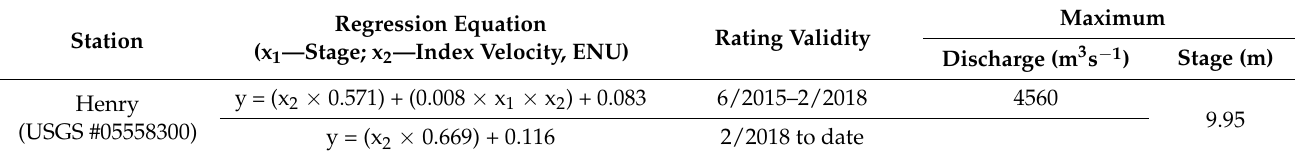
Table 1. IVRC regression equations (source: https://waterdata.usgs.gov/monitoring-location/0555 8300, accessed on 20 April